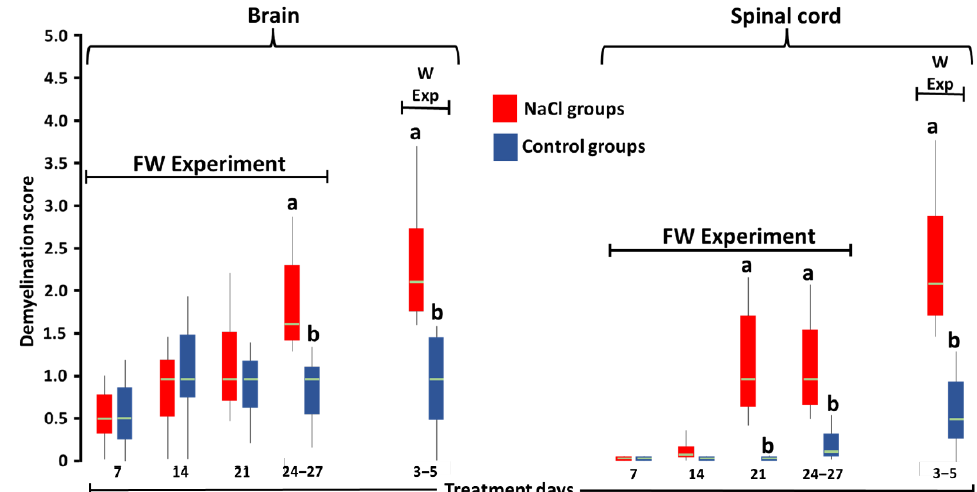
Figure 2. Micrographs of HE-stained organs from chickens treated with 1% NaCl in the drinking water. ( a ) Kidney: pyknotic nuclei characteristic of acute proximal tubular necrosis (arrows). ( b ) Kidney: mesangioproliferative glomerulopathy (inset). ( c ) Kidney from the control group that con- sumed food with 0.3% NaCl and drinking water. ( d ) Brain with white matter demyelination (inset). ( e ) Spinal cord with white matter demyelination. ( f ) Brain from a control chicken that consumed food with 0.3% NaCl and drinking water. ( g ) Liver: thin granules degeneration and loss of hepato- cyte contours (proteinaceous degeneration). ( h ) Liver: thick vacuolar (hydropic) degeneration and (g, and h) dilatation of blood vessels (hyperemia) are observed. ( i ) Liver from a control chicken that consumed food with 0.3% NaCl and drinking water.